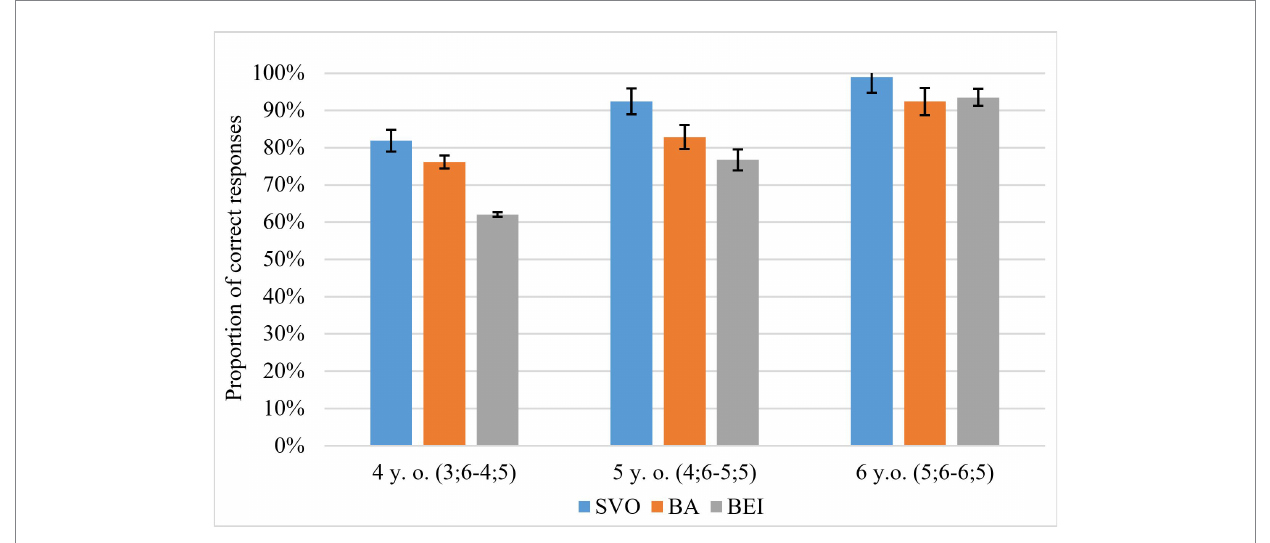
FIGURE 5 Proportion of correct responses in sentence production. Error bars represent ±SEM.